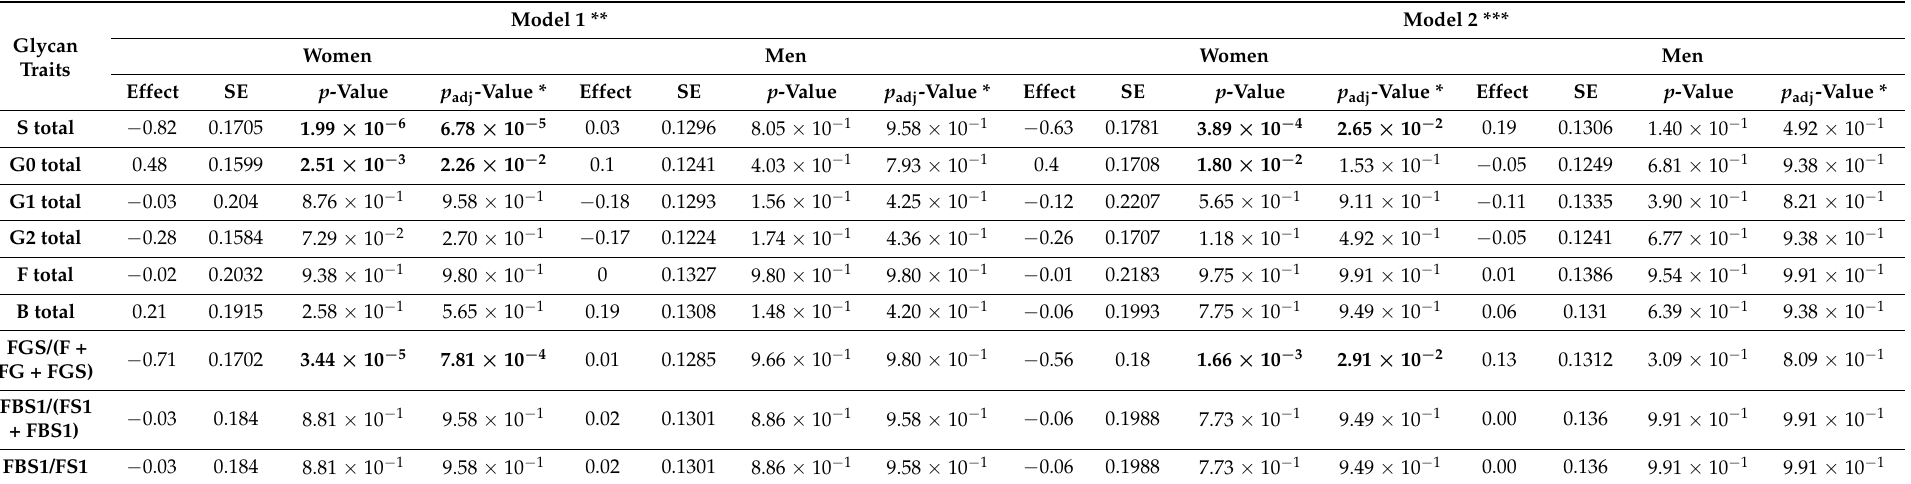
Table 2. Statistical analysis of IgG N-glycan derived traits in CAD+ versus CAD − cases at inclusion